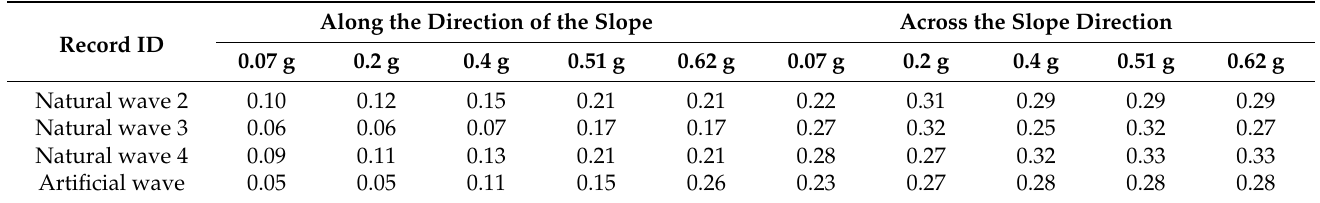
Table 2. The proportion of the base shear borne by lower embedding